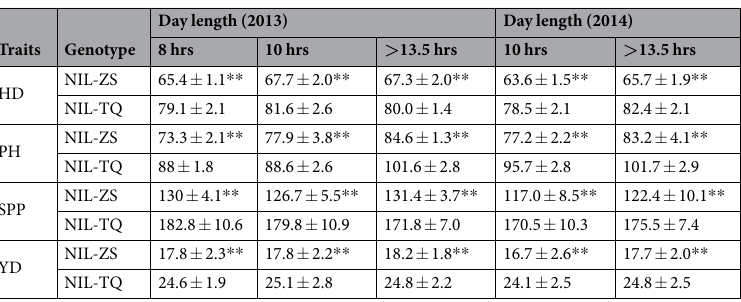
Table 1. Performance of near isogenic lines for Ghd6 / Hd1 under short day and long day conditions. HD, heading date; PH, plant height; SPP, spikelets per panicle; YD, yield; > 13.5 hrs the natural day length is more than 13.5 hours in the period from sowing to heading (May 10 to August 5) in Wuhan; NIL-ZS, Homozygotes plants containing ZS97 region of Ghd6 / Hd1 in ZS97 background; NIL-TQ, Homozygotes plants containing TQ region of Ghd6 / Hd1 in ZS97 background. “ ** ” mean the significantly difference by Duncan test P ≤ 0.01 when NIL-ZS compared to